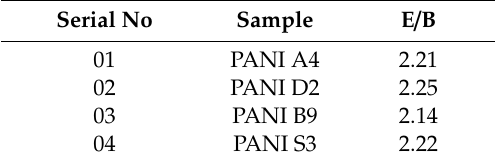
Table 6. The extent of doping of DBSA into PANI Chain.